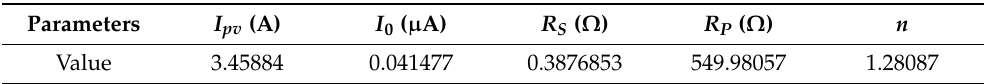
Table 9. The estimated value of the parameters of the commercial solar